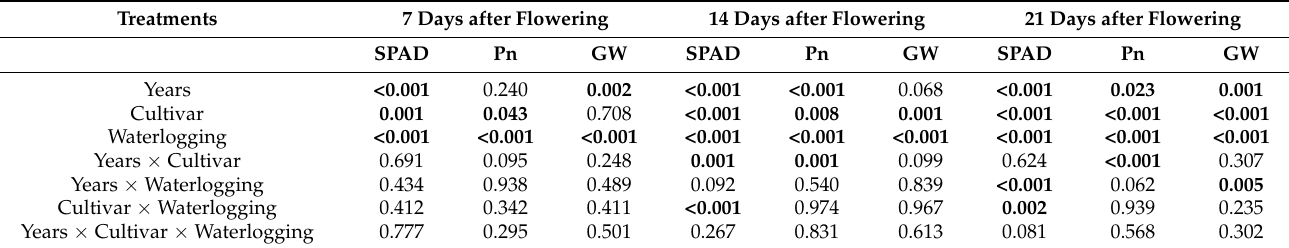
Table 2. ANOVA ( p -value) for the effects of cultivars, waterlogging, and growing seasons and their interactions on some shoot and yield traits.